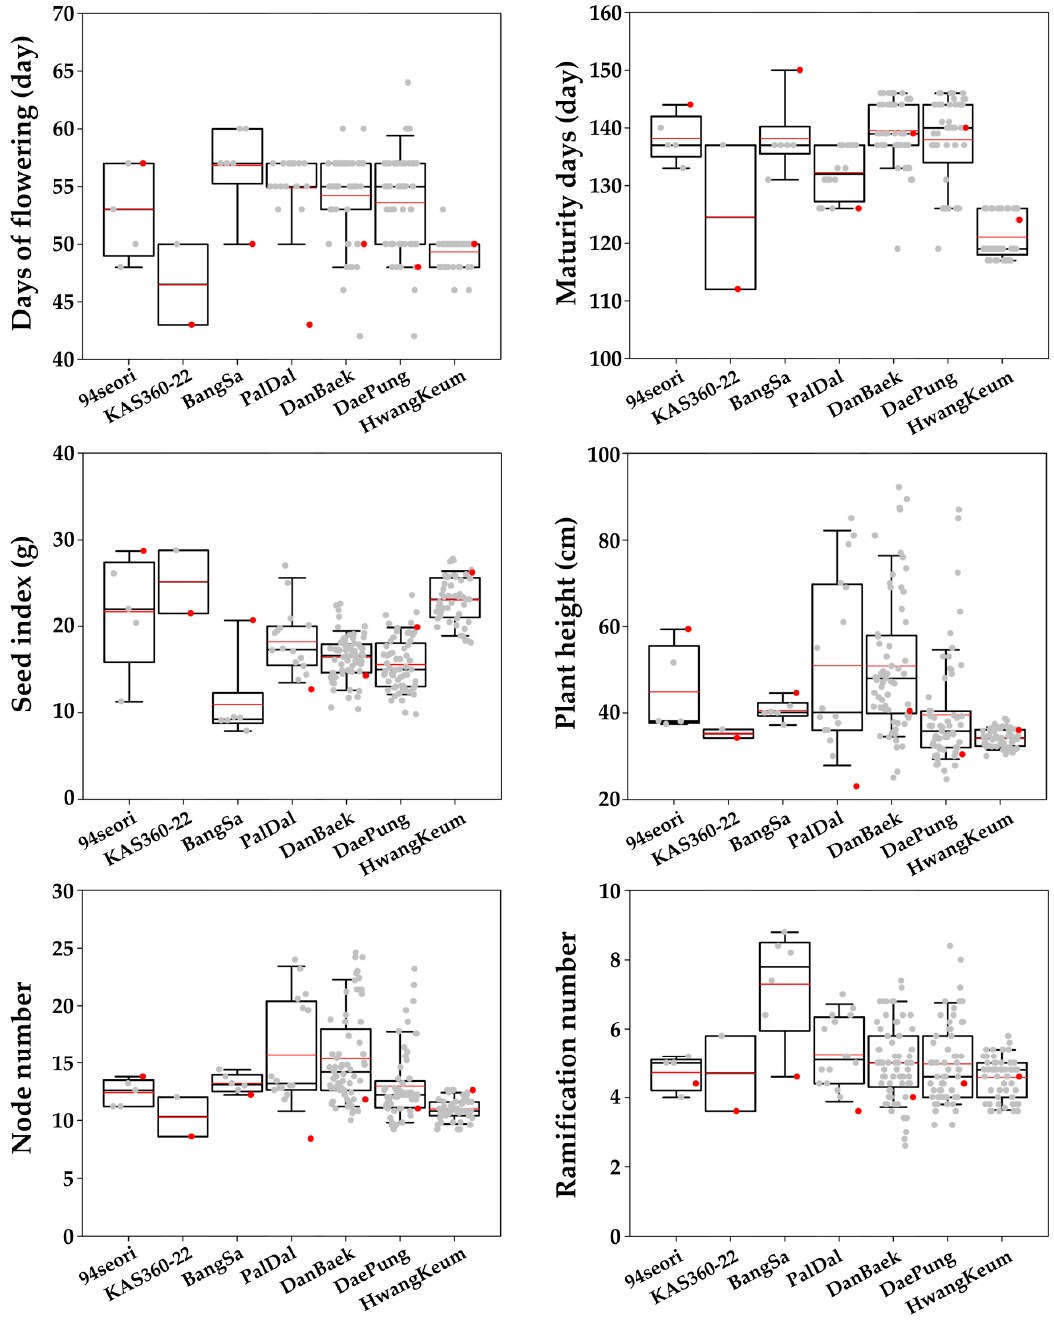
Figure 3. Changes in the phenotypes of six quantitative traits in 208 MDP lines. The box plots of phenotypic distributions in seven MDP lines and their wild types are shown. The data shown are the mean values of individual mutants (gray) and wild types (red).